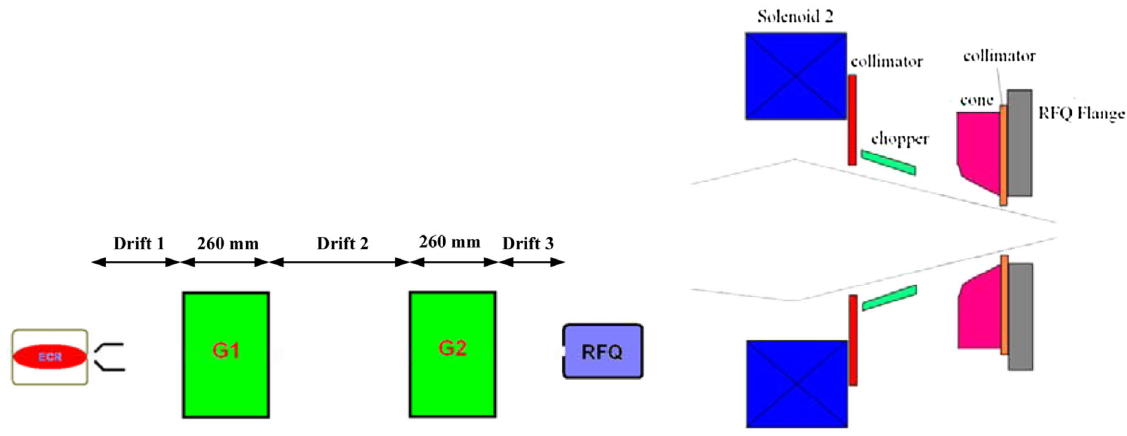
FIG. 4. Schematic for the LEBT (left) and the chopper (right). G1 and G2 are for Glaser magnetic lenses.